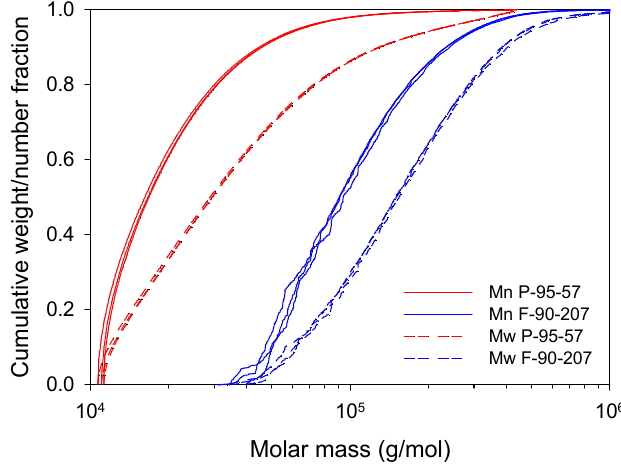
Figure 1. Cumulative weight (Mw)/number (Mn) fraction as a function of molar mass for chitosan powder and flakes.